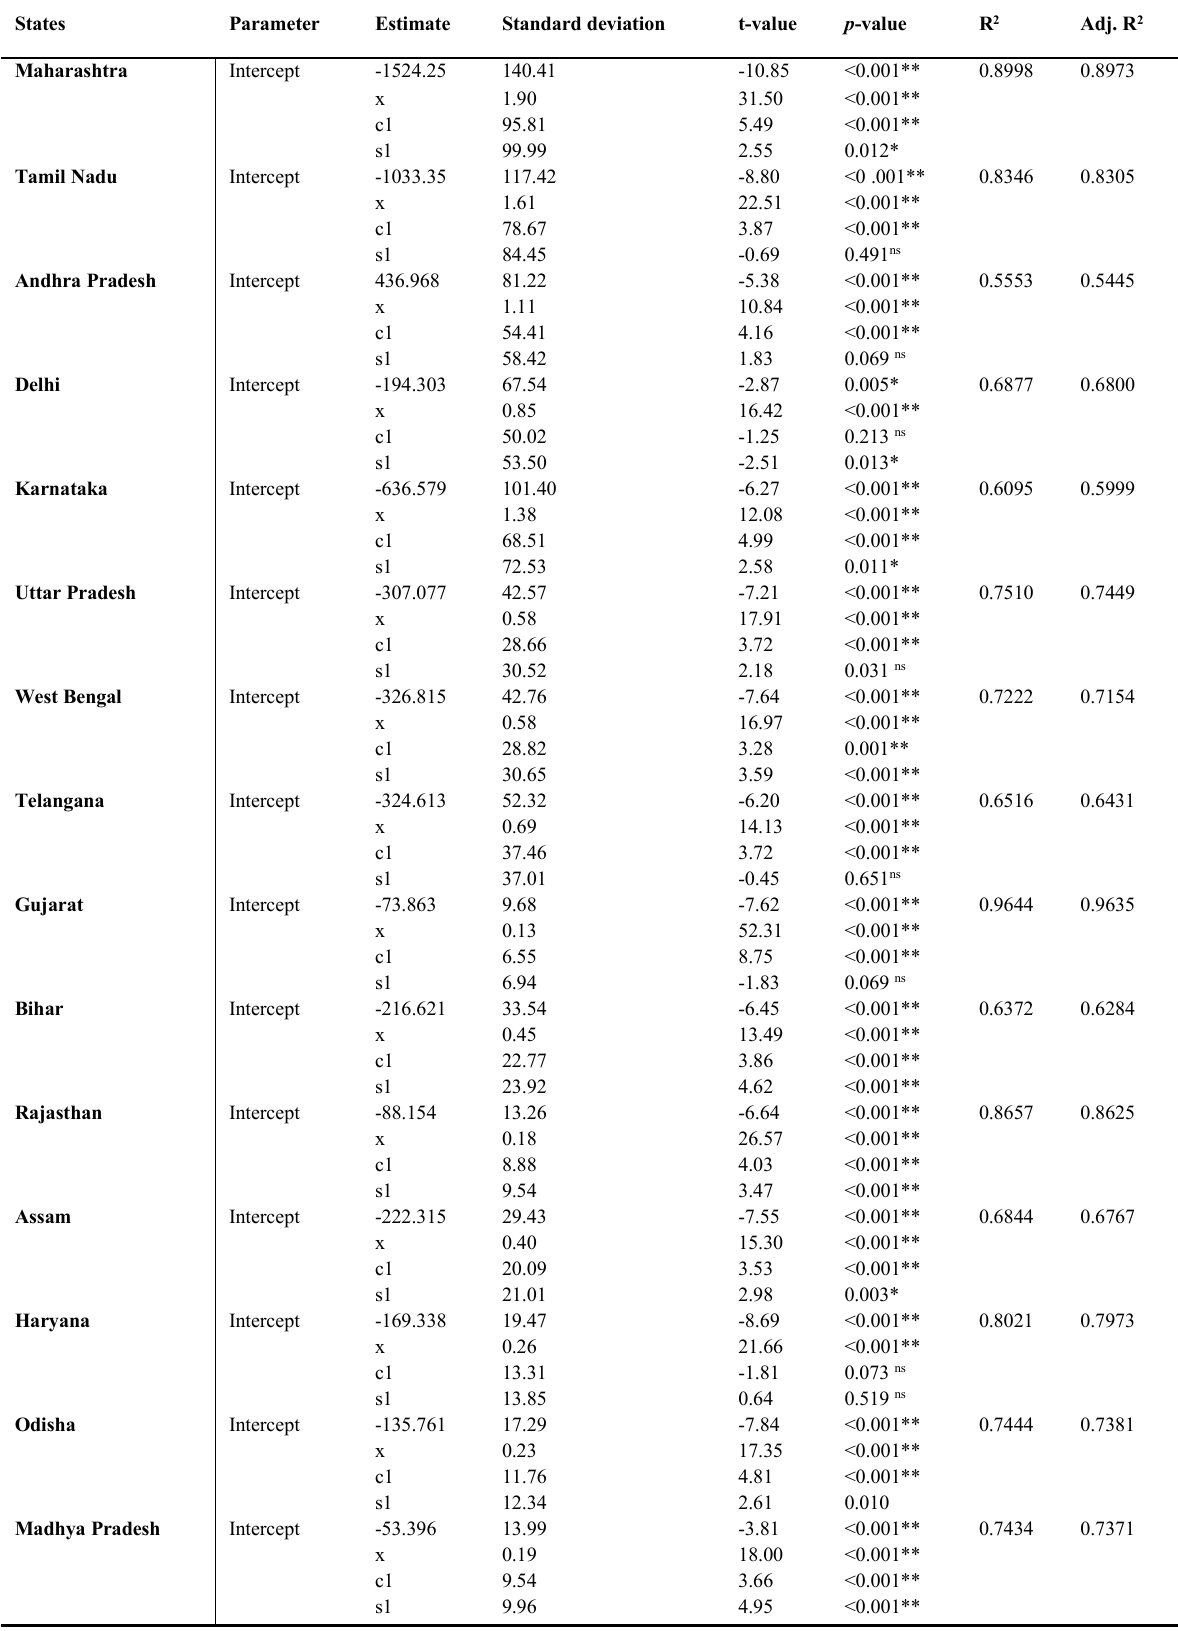
Table 1 . Periodic regression analysis values of COVID-19 disease outbreaks in the top 15 highly infected states in India.